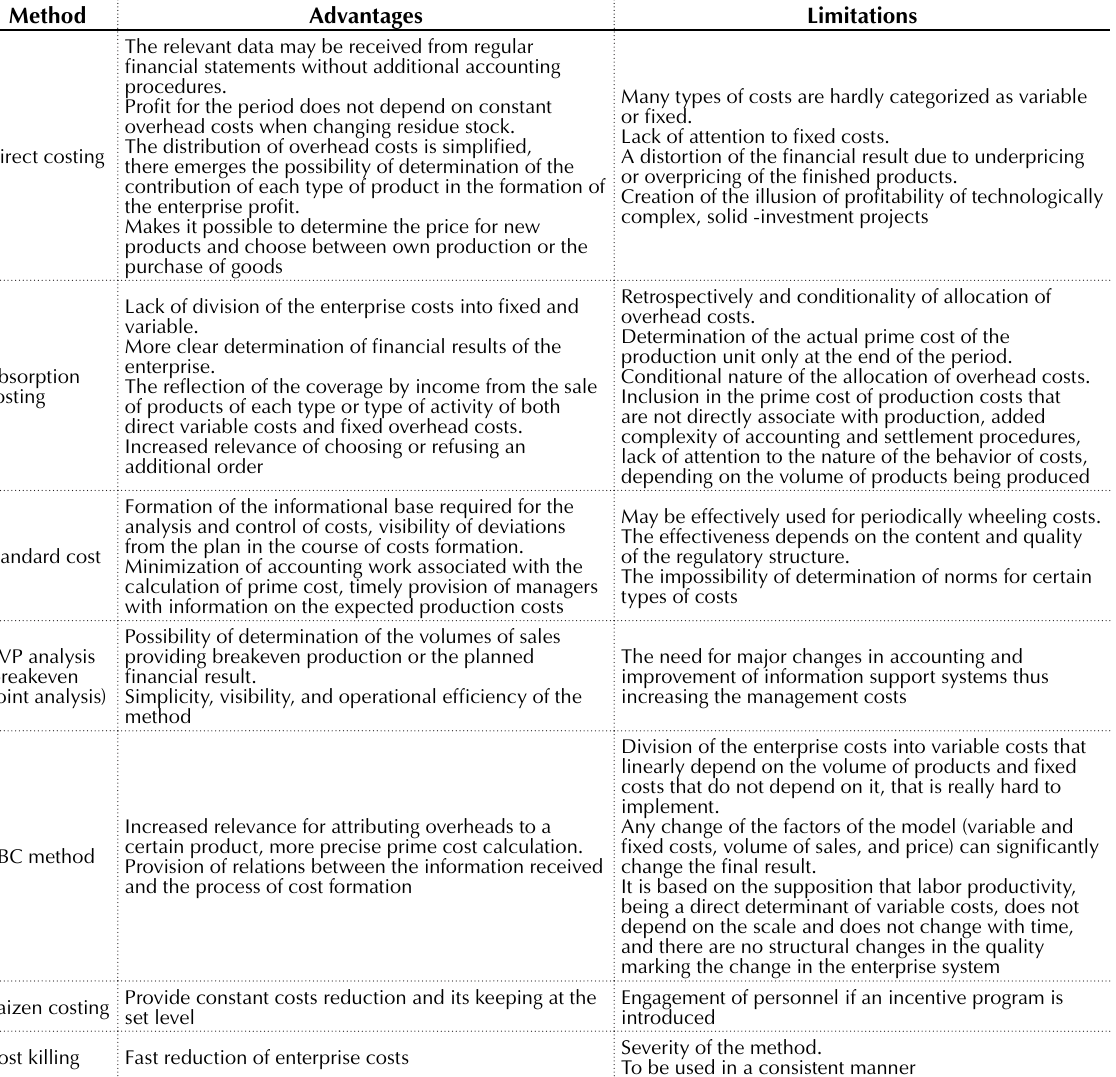
Table 2. Advantages and limitations of the methods of operational enterprise cost